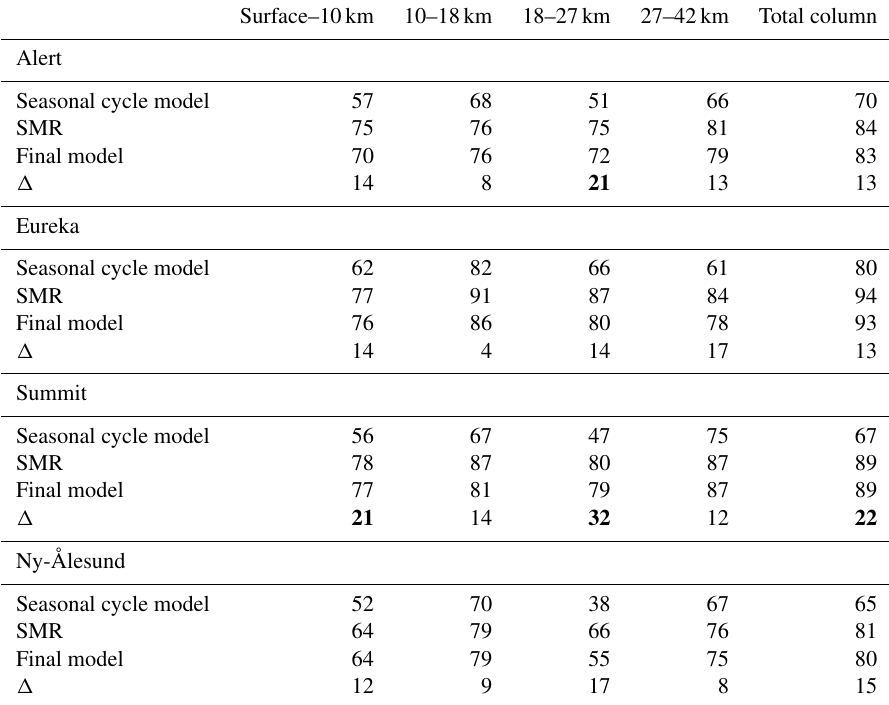
Table 2. Correlation of determination ( R 2 in %) for the seasonal cycle, stepwise regression model (SMR), and the final model of ozone variations (February 2005–February 2017). The improvement in the correlation of determination between the seasonal cycle and final models is shown as (cid:49) for each station. The text is in bold when the improvement is higher than